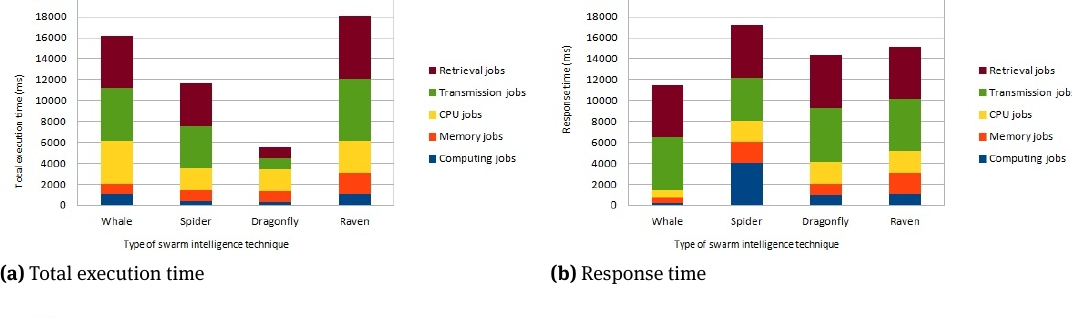
of successful completion of jobs is higher for raven compared to whale, spider, and dragonfly. With respect to retrieval jobs , the total execution time of dragonfly and spider is lower compared to whale and raven, the response time of all algorithms i.e., whale, spider, dragonfly, and raven fall in average range, the resource uti- lization rate of spider and whale is higher compared to dragonfly and raven, the rate of successful completion of jobs is higher for raven compared to whale, spider, and